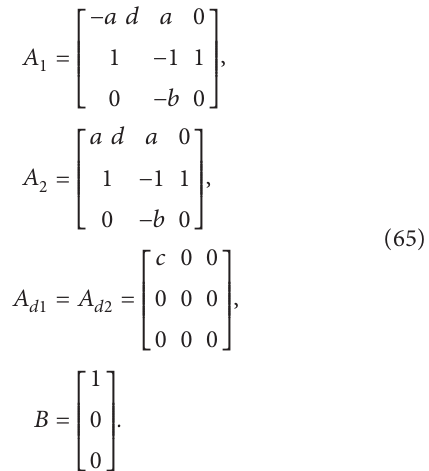
( t ) , (b) e ( t ) , and (c) x ( t ) d 3 h 3 3